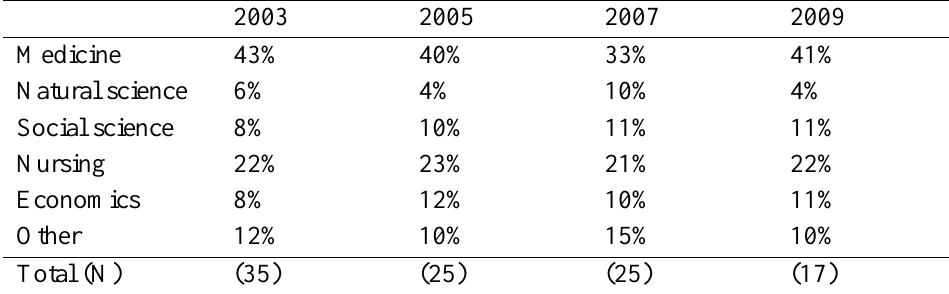
Professional background of division managers from 2003 to